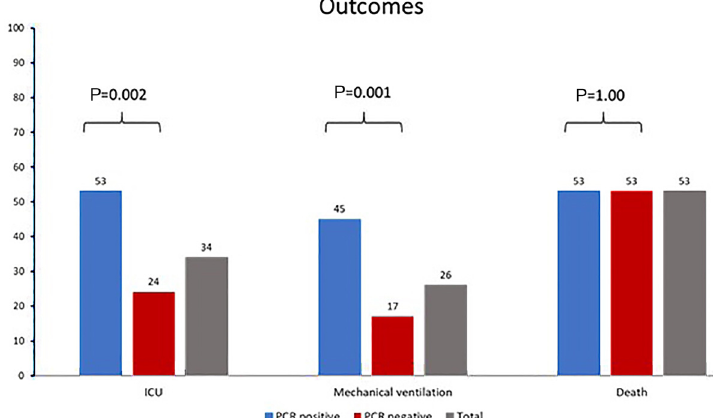
Figure 1. Percent of admissions to intensive care unit (ICU), mechanical ventilation, and deaths, according to RT-PCR SARS-CoV2 status. Fisher ’ s exact